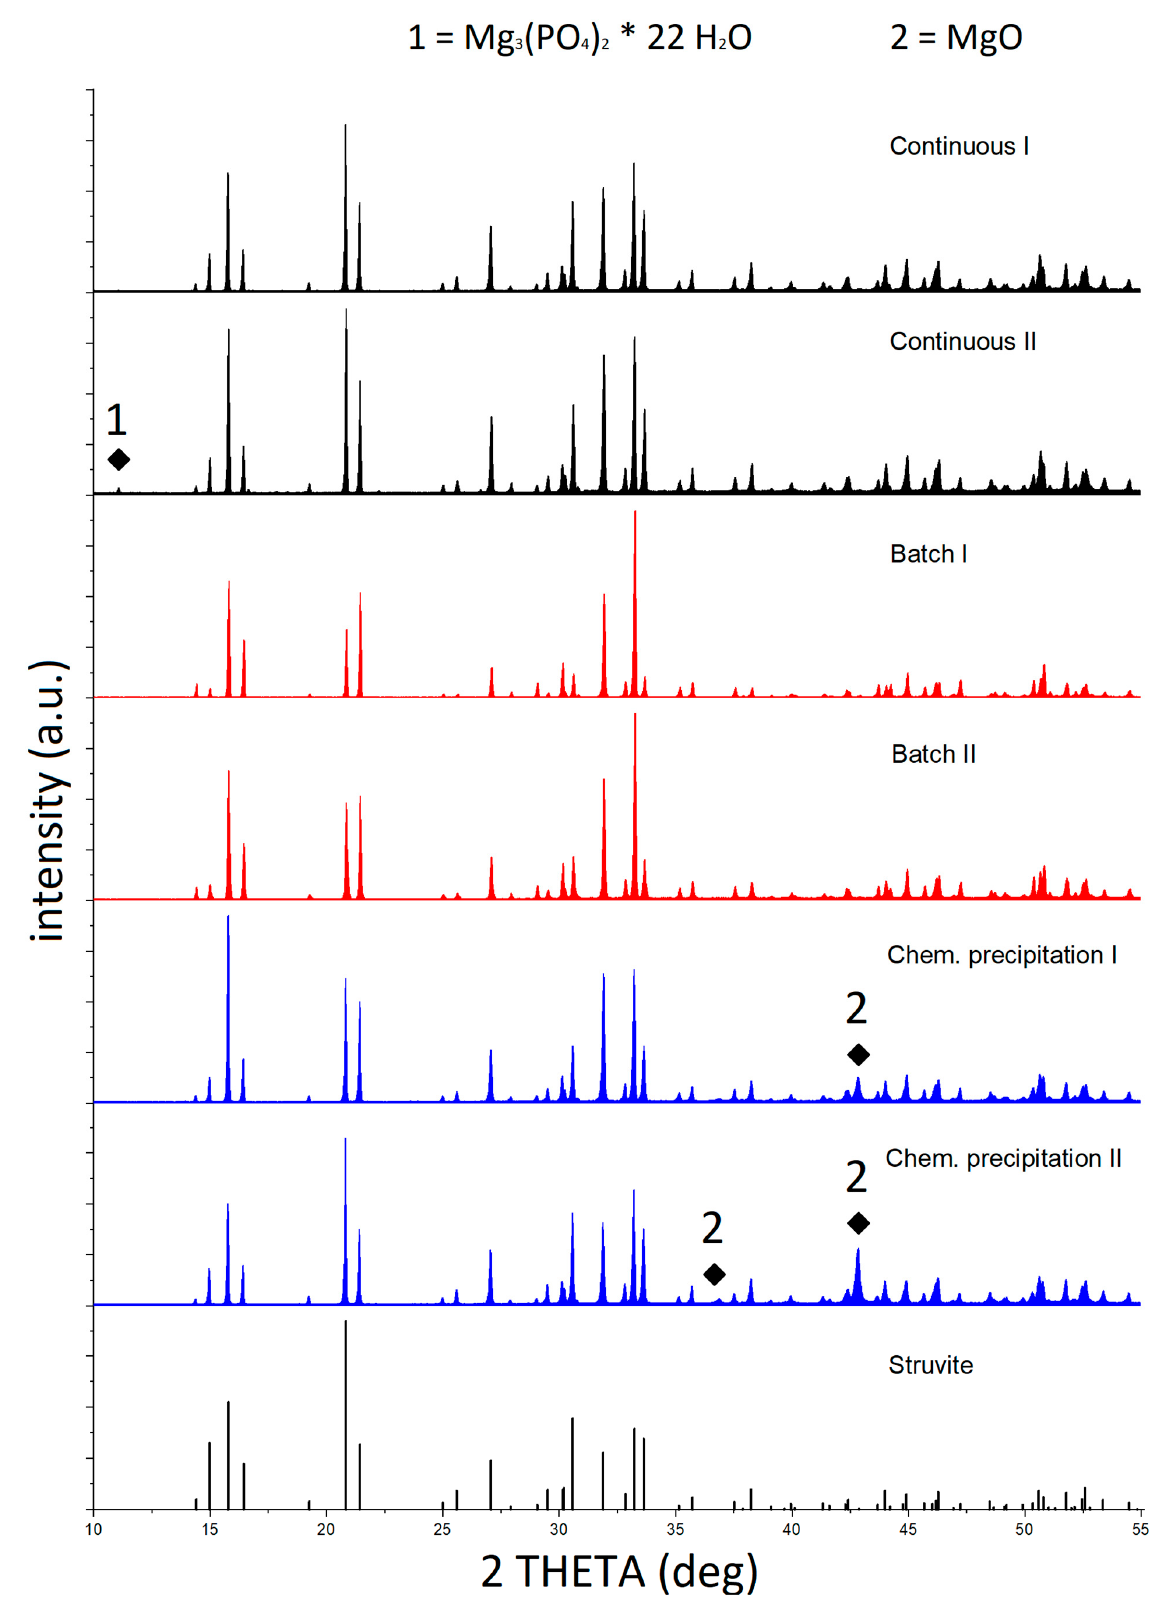
Figure 4. XRD patterns for the sludges obtained from the authentic water samples subjected to BEC, CEC, and CP for struvite precipitation.